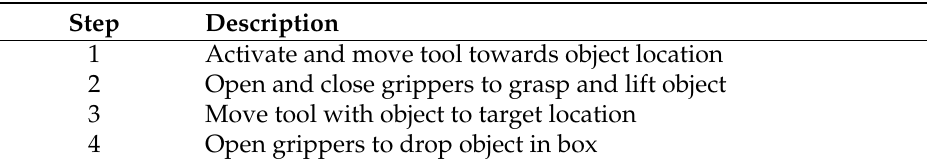
Figure 5. Snapshot views of the four successive steps [15]. Table 2. Four-step pick-and-drop task.